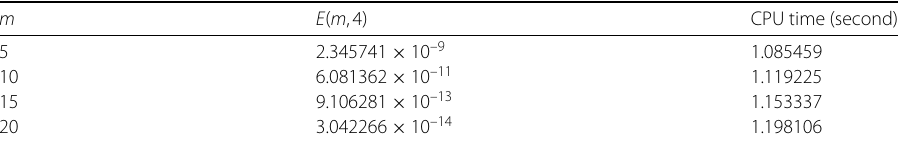
Table 6 Averaged square error of numerical solution and the required CPU time of approach II for λ = 1 and j = 4